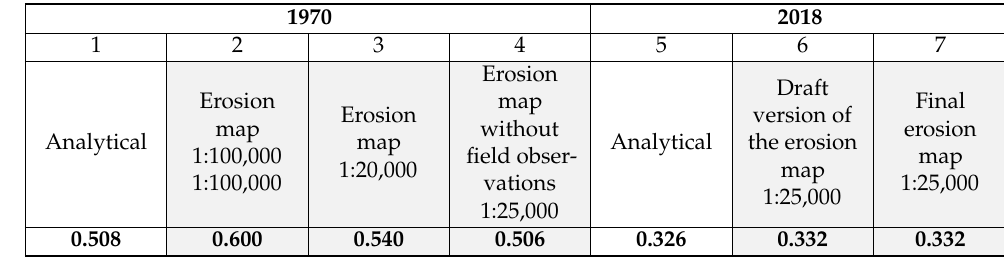
Table 4. Arithmetic means of the average erosion coefficients obtained by different methods for the two periods (1970 and